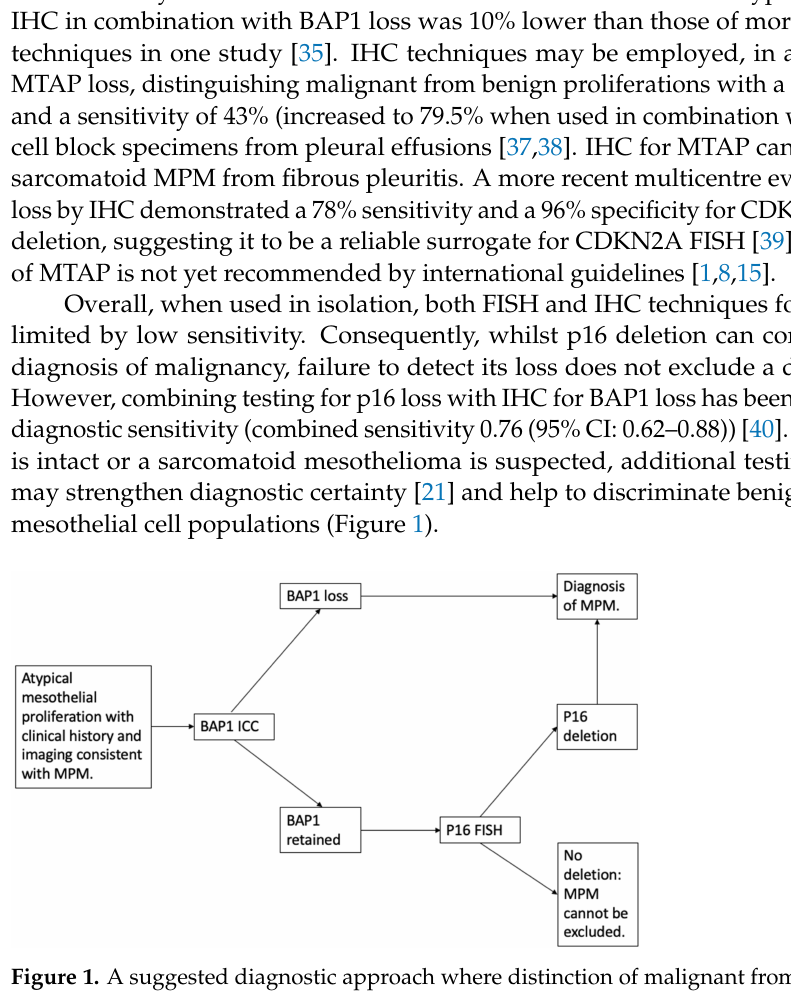
Figure 1. A suggested diagnostic approach where distinction of malignant from benign mesothelial proliferation is unclear on initial fluid cytology. BAP1 loss and p16 deletion support the diagnosis of MPM. MPM, malignant pleural mesothelioma; ICC, immunocytochemistry; FISH, fluorescence in-situ hybridization; BAP1, BRCA 1-associated